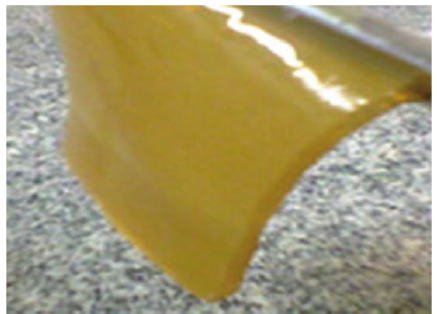
Figure 22: Nanocellulose and propolis-based bandage [213].